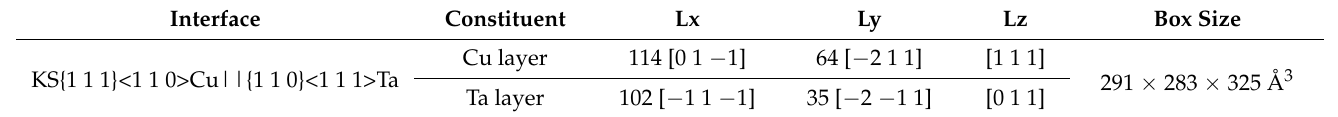
Table 1. This simulation is carried out by using the Large-scale Atomic/Molecular Massively Parallel Simulator (LAMMPS) code [36]. First, the conjugate gradient (CG) method is adopted to derive a minimum equilibrium energy model. The stopping tolerances for energy and force are 10 − 6 eV and 10 − 12 ev/Å, respectively. Then, the system is further balanced via a Nos é –Hoover thermostat [37]. During the relaxation period, the system uses isothermal–isobaric (NPT) ensembles, and the pressure in the three-axis directions is set to zero for 50 ps. Previous studies of face-centered cubic (FCC)/body-centered cubic (BCC) interface multilayers have shown that the behavior of defect evolution and deformation mechanisms in the fcc phase has not varied significantly in the strain rate range of 10 7 –10 9 1/s [31]. Therefore, uniaxial compressive deformation was performed along the z-axis direction with a strain rate of 1.0 × 10 9 s − 1 . The system fixes the pressure on the x- and y-axis direction to zero during the deformation process. The temperature during the simulation can be controlled by setting the temperature parameters of the Nos é –Hoover thermostat and NPT ensembles. Table 1. Orientations and sizes of Cu/Ta MNCs with Kurdjumov–Sachs orientation–related interfaces. Interface Constituent Lx Ly Lz Box